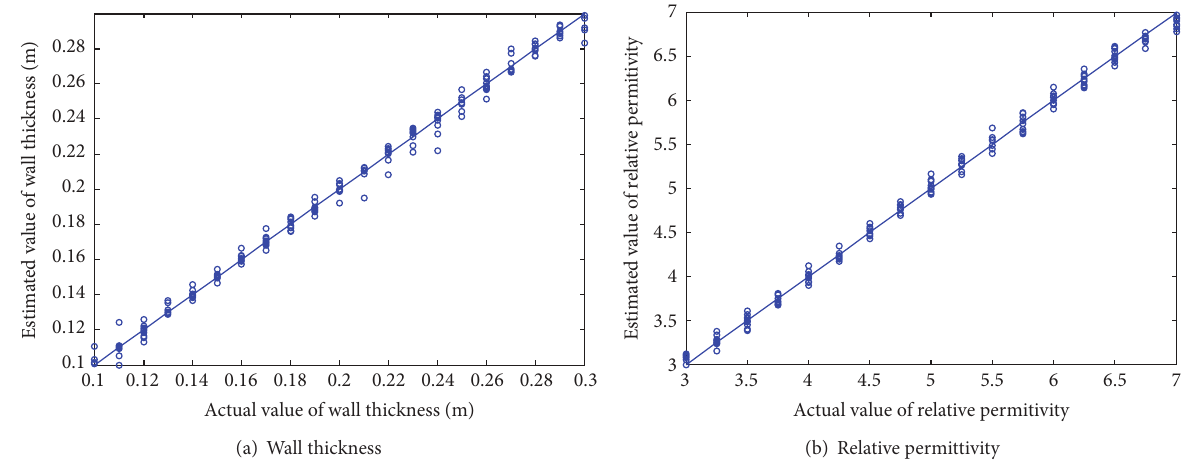
Figure 2: Estimated and actual values of the wall